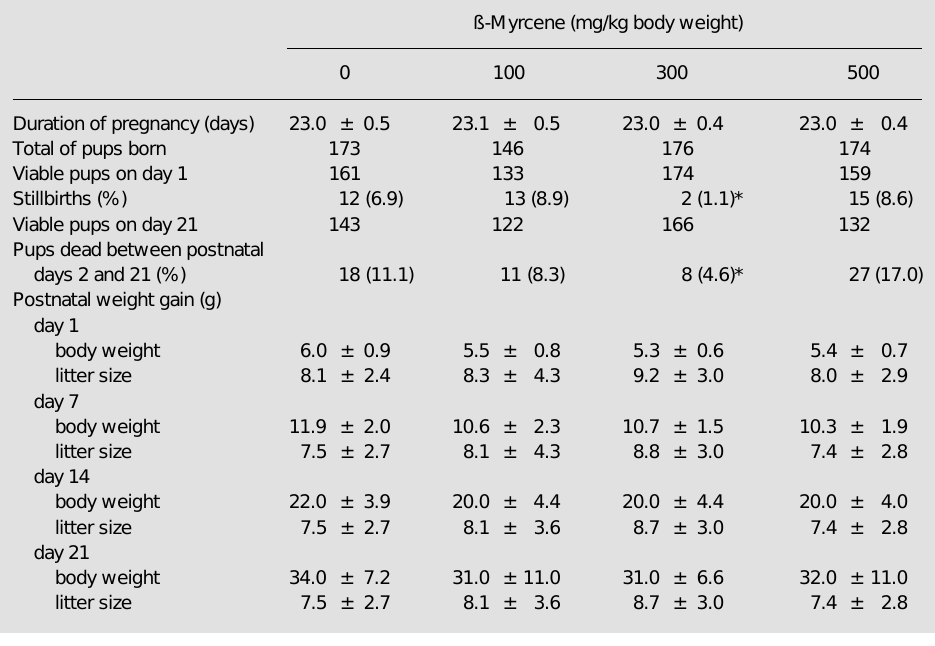
Table 5 - Duration of pregnancy, number of stillbirths, postnatal mortality and weight gain of offspring of rats treated orally with ß-myrcene (0, 100, 300 and 500 mg/kg body weight) during pregnancy and lactation. Data were analyzed by the chi-square test (proportions), Kruskal-Wallis (duration of pregnancy) and ANOVA (body weight and litter size). % of stillbirths = [No. of stillbirths/total of pups born] x 100; % of pups dead = [No. of pups dead/No. of viable pups on day 1] x 100. *P<0.05 compared to control group.